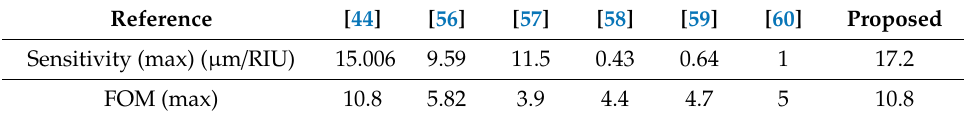
Figure 6. ( a ) Spectral shift of mode A and mode B with different sensing medium refractive indices (1.0–1.5) (the insert map is spectral shift of mode A); ( b ) a linear relationship of resonance wavelengths in response to changes in the refractive index; ( c ) FWHM (FWHM is the full width of half maximum) and figure of merit (FOM) of mode A and mode B in response to different sensing medium refractive indices. Table 1. Comparison of sensitivity (S) and the figure of merit (FOM) of different structures proposed in previous publications.